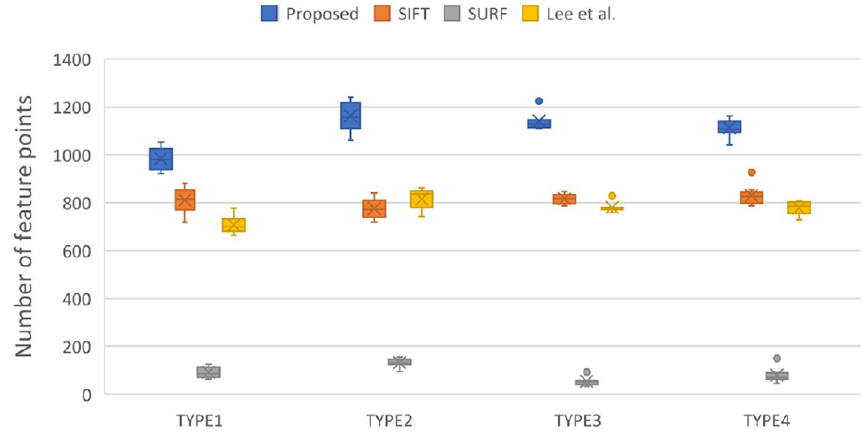
Figure 2. Compare the number of feature point detection by four methods in each types.